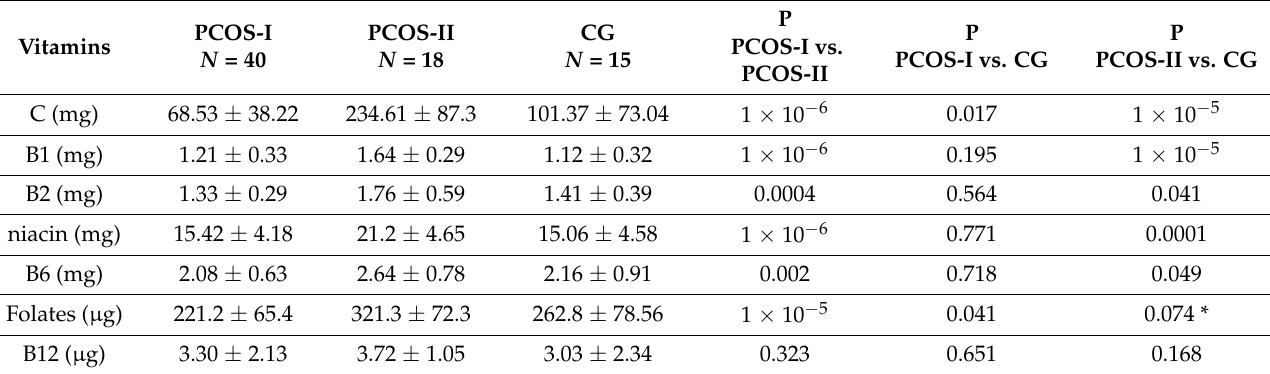
Table 2. The comparison of the consumption of vitamins with reference to the analysed groups (PCOS-I, PCOS-II, and CG).